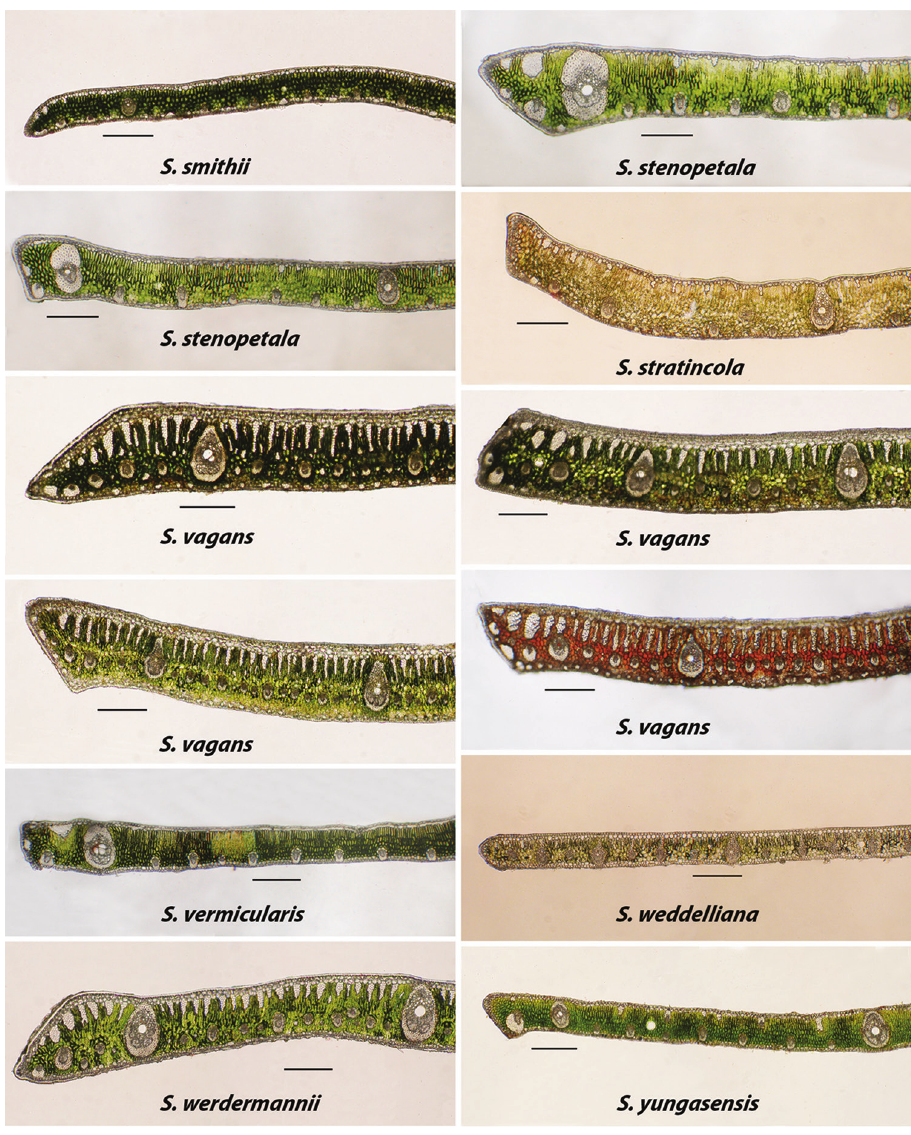
Figure 8. Alphabetically arranged marginal leaflet transections. Syagrus smithii to S. yungasensis . Note variation in S. stenopetala and S. vagans . Bar scale = 0.25